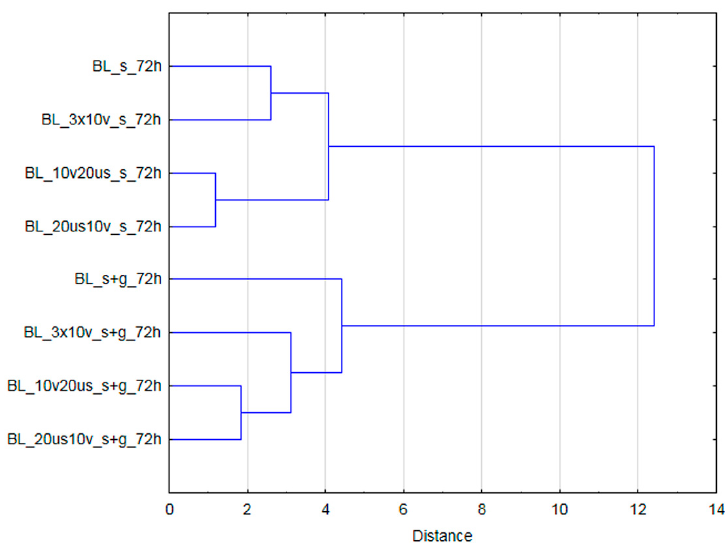
Figure 7. The results of cluster analysis (considering all analyzed variables) for samples subjected to osmotic dehydration.